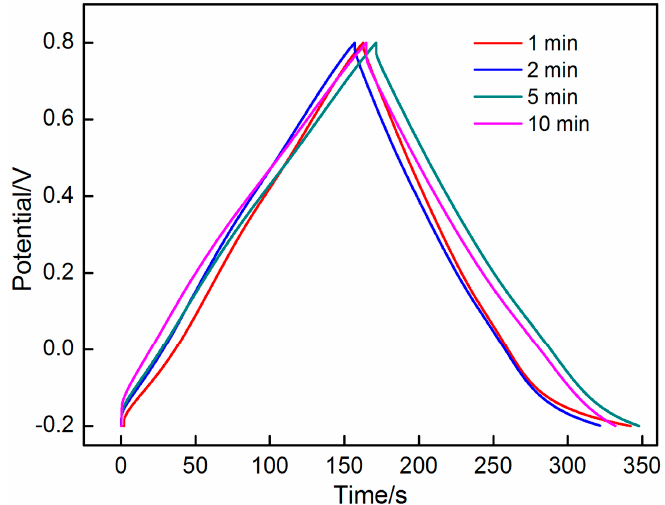
Figure 16. Galvanostatic charge/discharge profiles of the MnO 2 -based electrode at different deposition time from 1 min to 10 min.